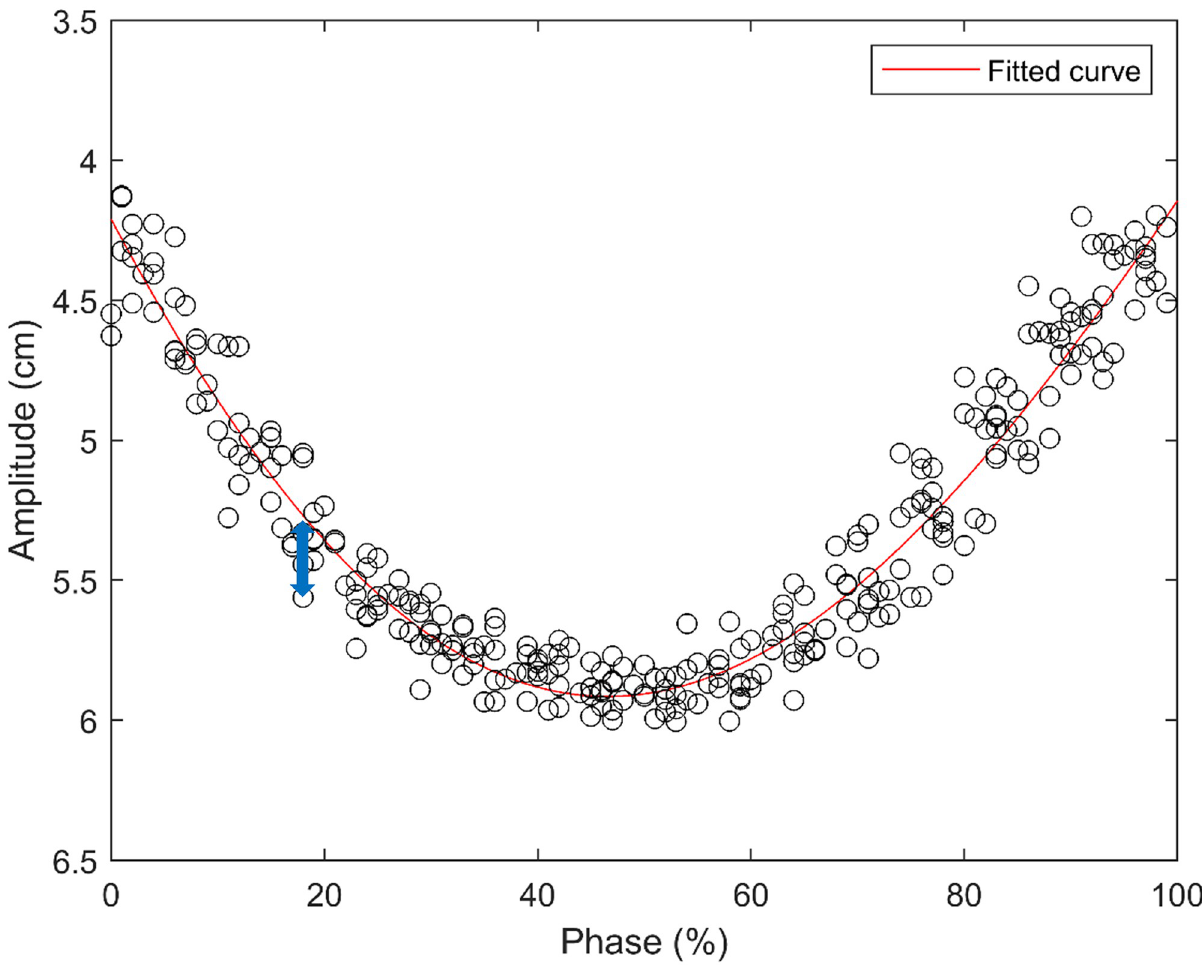
Fig 7. Plot of amplitude versus phase information of the surrogate respiratory signal and the representative respiratory signal fitted to the combination of sinusoidal functions.